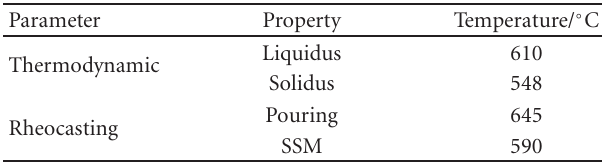
Table 1: Calculated thermodynamic and deduced rheocasting parameters of A356 for the three-coil CSIR-RCS-HPDC cell.